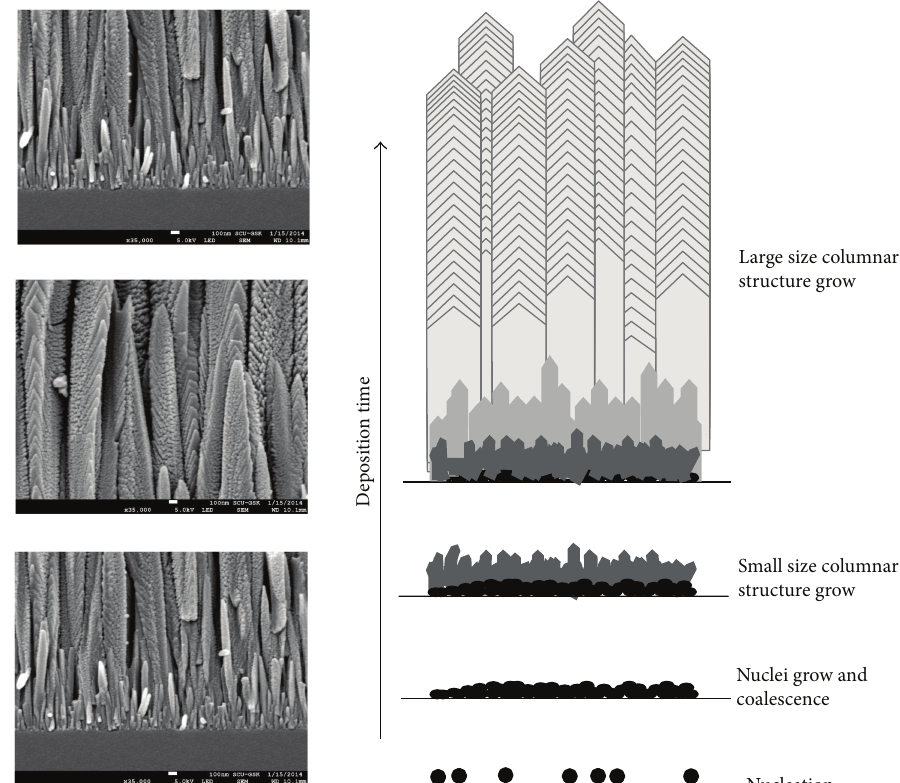
Figure 6: Proposed growth mechanism for the hierarchically structured TiO 2 films by CVD.